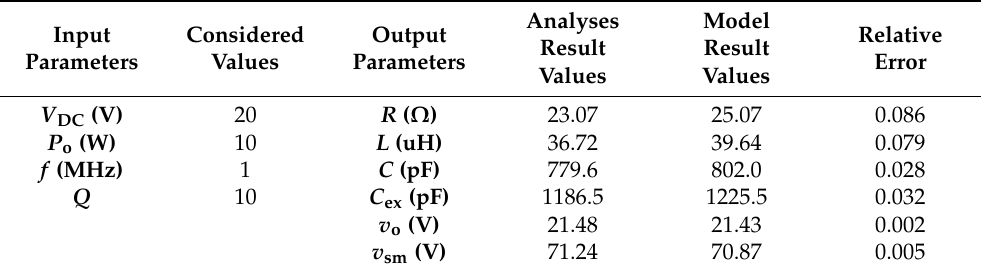
Table 7. Comparison between the final model and analysis results of the presented design example at 1